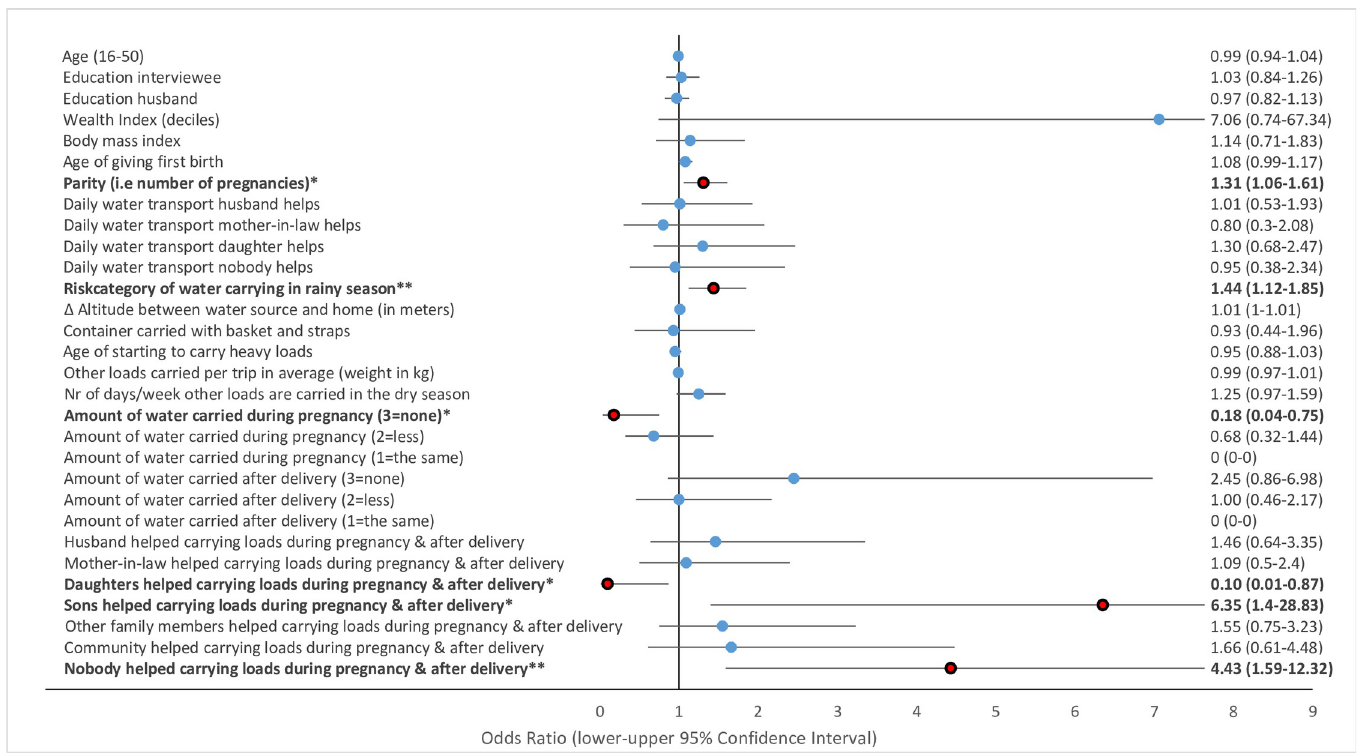
Fig 2. Association of risk factors with strong back pain in multivariate GLMM. ( ��� = significant at the p < 0.001-level, �� = significant at the p = 0.01-level, � = significant at the p = 0.05-level; = odds ratio statistically non-significiant, ... = odds ratio statistically significant).